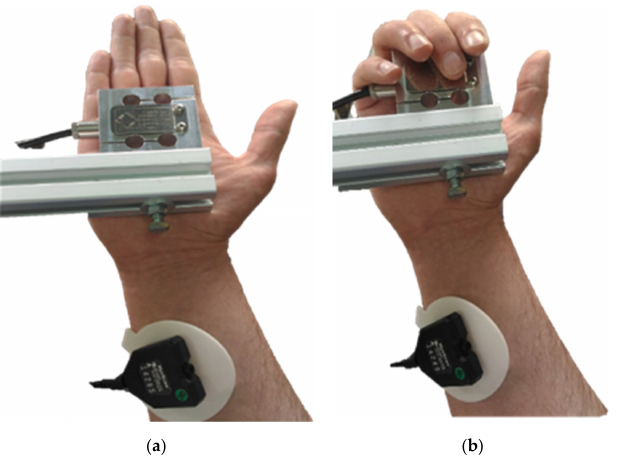
Figure 8. Measurement of the effort by the load cell: ( a ) stretched fingers; ( b ) flexed fingers. Three qualitative effort levels were determined for each movement: light, medium and high, according to the light (about 25 N), medium (about 35 N) and high (about 60 N) finger effort levels of the subjects on the load cell. Given a subject, for each effort level and each movement, EMG signals were collected in the same graph as for the referred load cell output signals. With reference to the third movement, Figure 9 shows the model-based EMG signals and the corresponding load cell output signals.